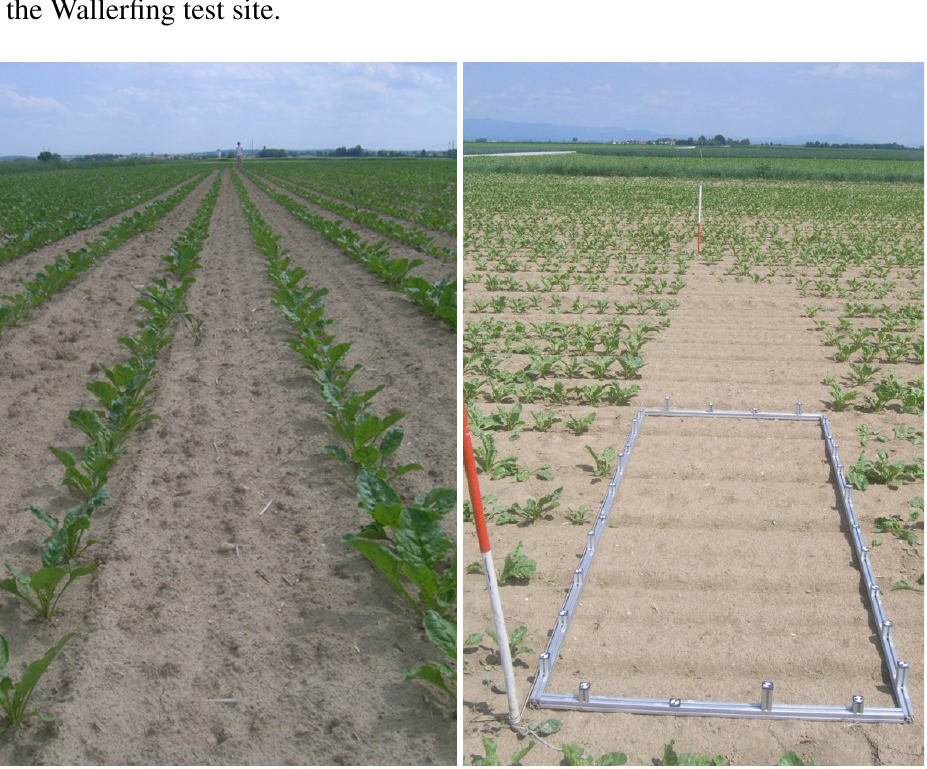
Figure 3. Overview of roughness sample point on a sugar beet field, acquired on 23 May 2011 at the Wallerfing test